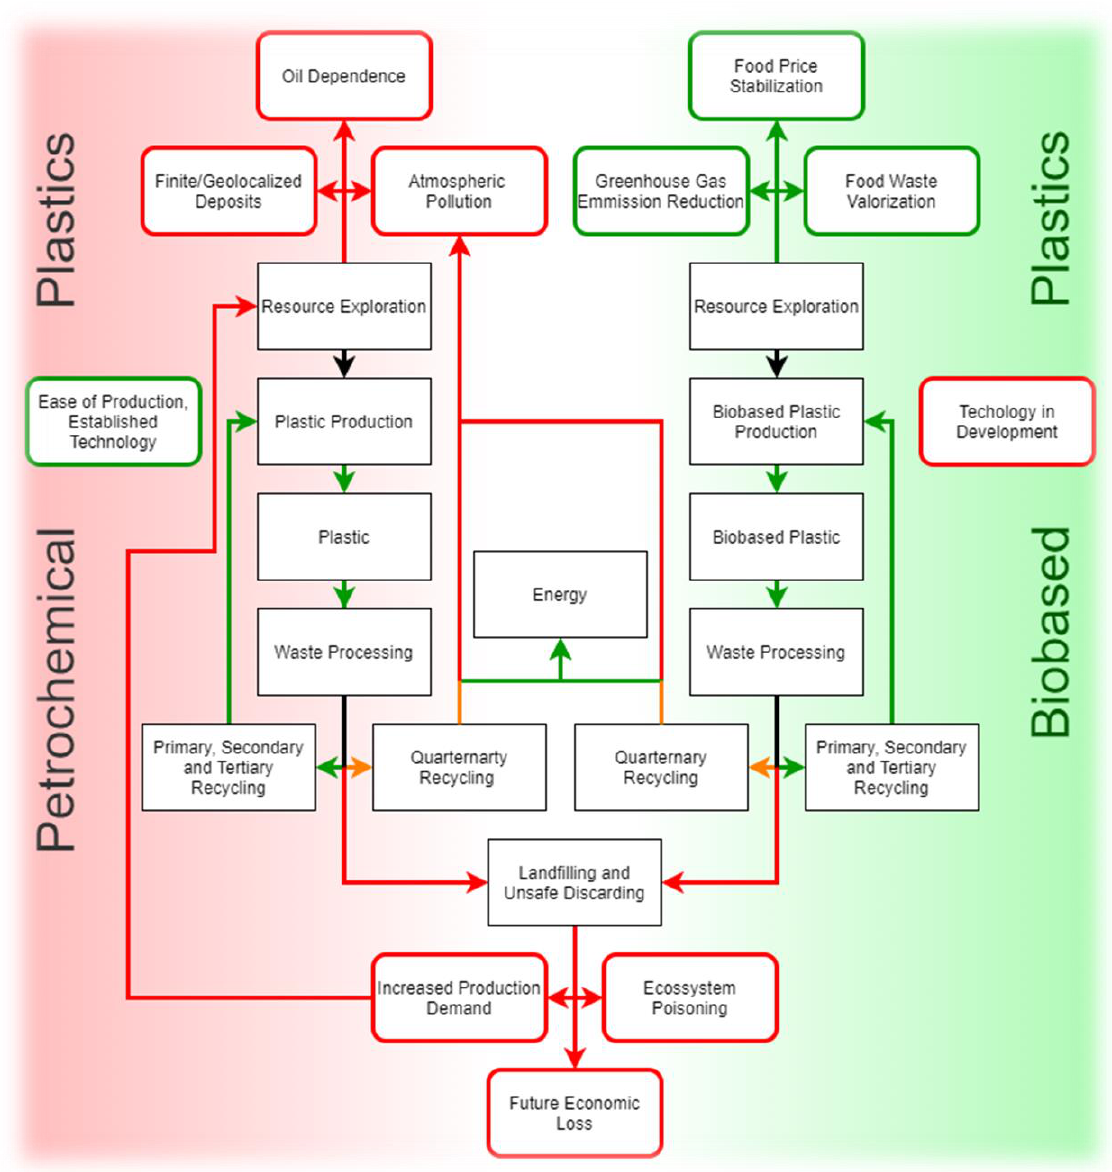
Figure 2. Schematic representation of petrochemical and biobased plastic life cycles, denoting some positive (green arrows) and negative (red arrows) effects of their use and disposal options.